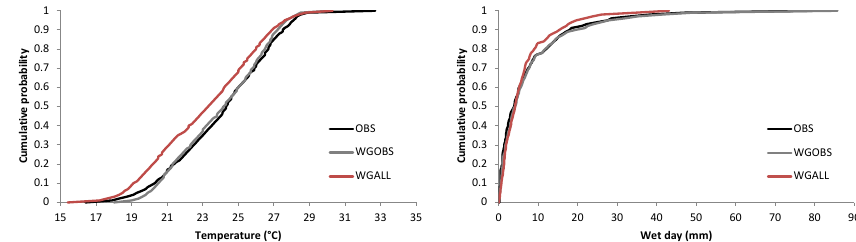
Figure 17 Observed (OBS) and generated (WGOBS, WGALL) cumulative distributions of daily mean temperature (left) and precipitation series (right) for years 1998 to 2005 at Taiz